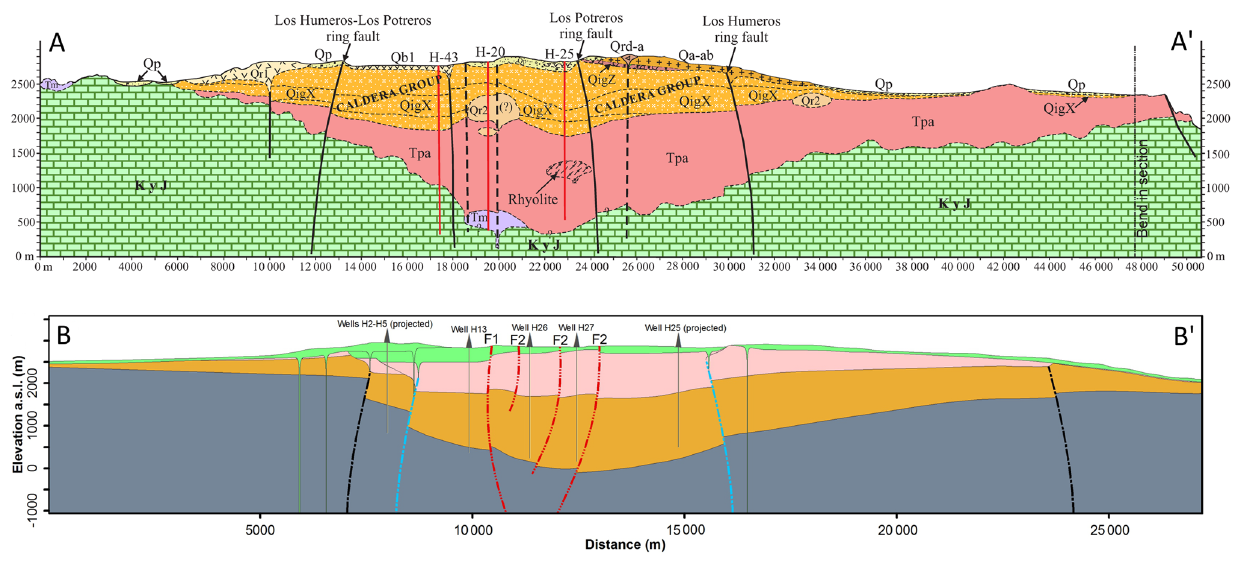
Figure 8. The two main cross-sections used for modelling the Los Humeros area. AA’ from Carrasco-Núñez et al. (2017b). BB’ from Norini et al. (2015). See Fig. 2 for